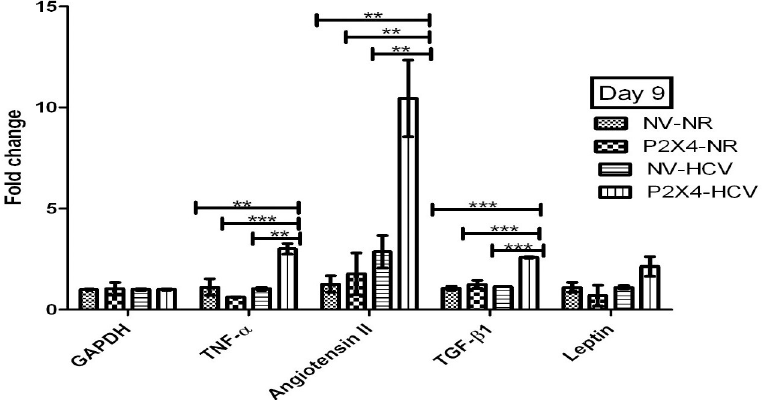
Fig 16. Expression of various cytokines on day 9 of post infection. All values are expressed as mean ± SEM, � P � 0.05 vs. control NV/HCV.